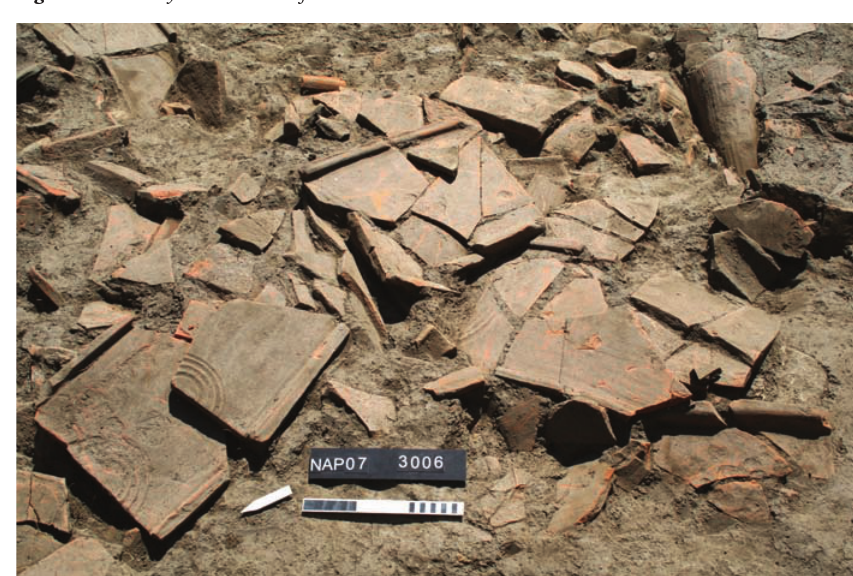
Figure 7 The collapsed roof of the probable military granary at Po şta